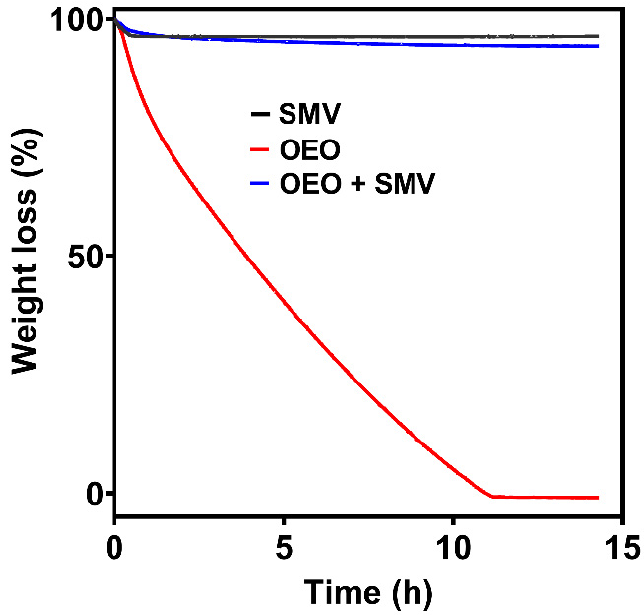
Figure 6. Isothermal release profiles of free OEO, SMV and OEO-loaded SMV.